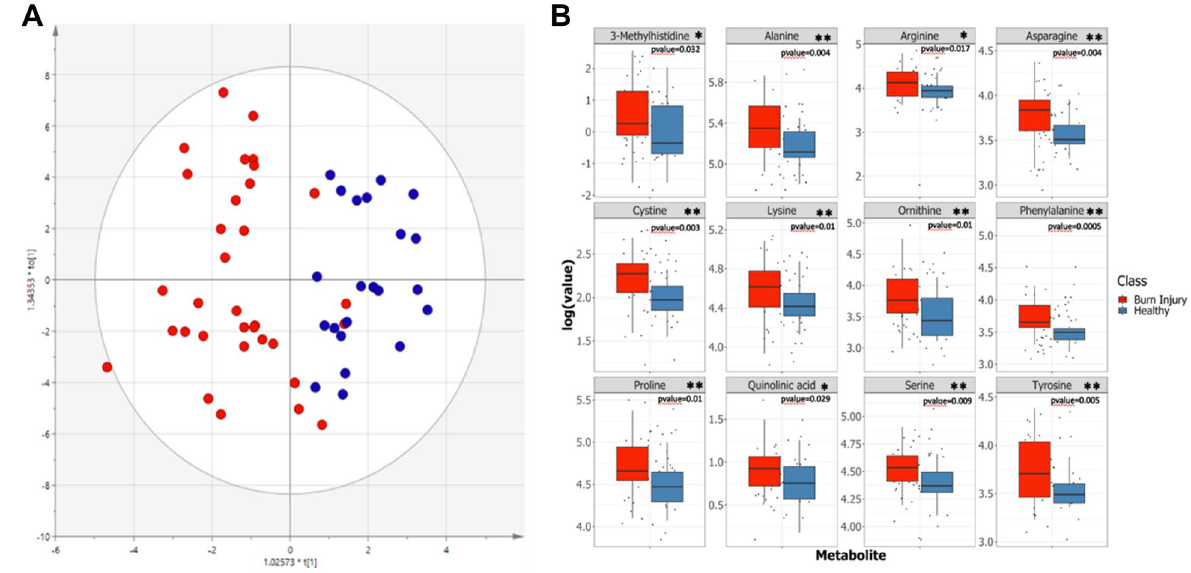
Figure 1. Orthogonal partial least square discriminant analysis (OPLS-DA). ( A ) OPLS-DA for class (burn injury or non-burn control) discrimination based on metabolic differences (R 2 X = 0.524, Q 2 Y = 0.2) ( B ) Log- scaled quantified metabolite concentrations, found to be significantly different between burn injury (n = 33) and non-burn (n = 33 age and gender matched (healthy)) controls ( p value * < 0.05, ** <